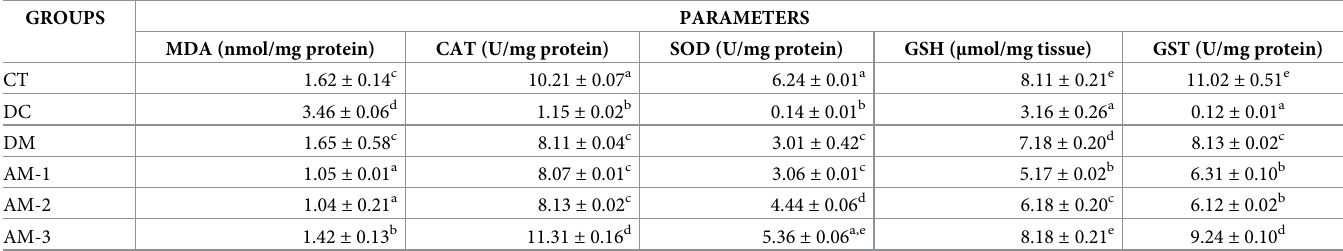
Table 7. Pancreatic antioxidant markers of alloxan-induced diabetic rats after oral administration of aqueous extract of A . muricata peels. GROUPS